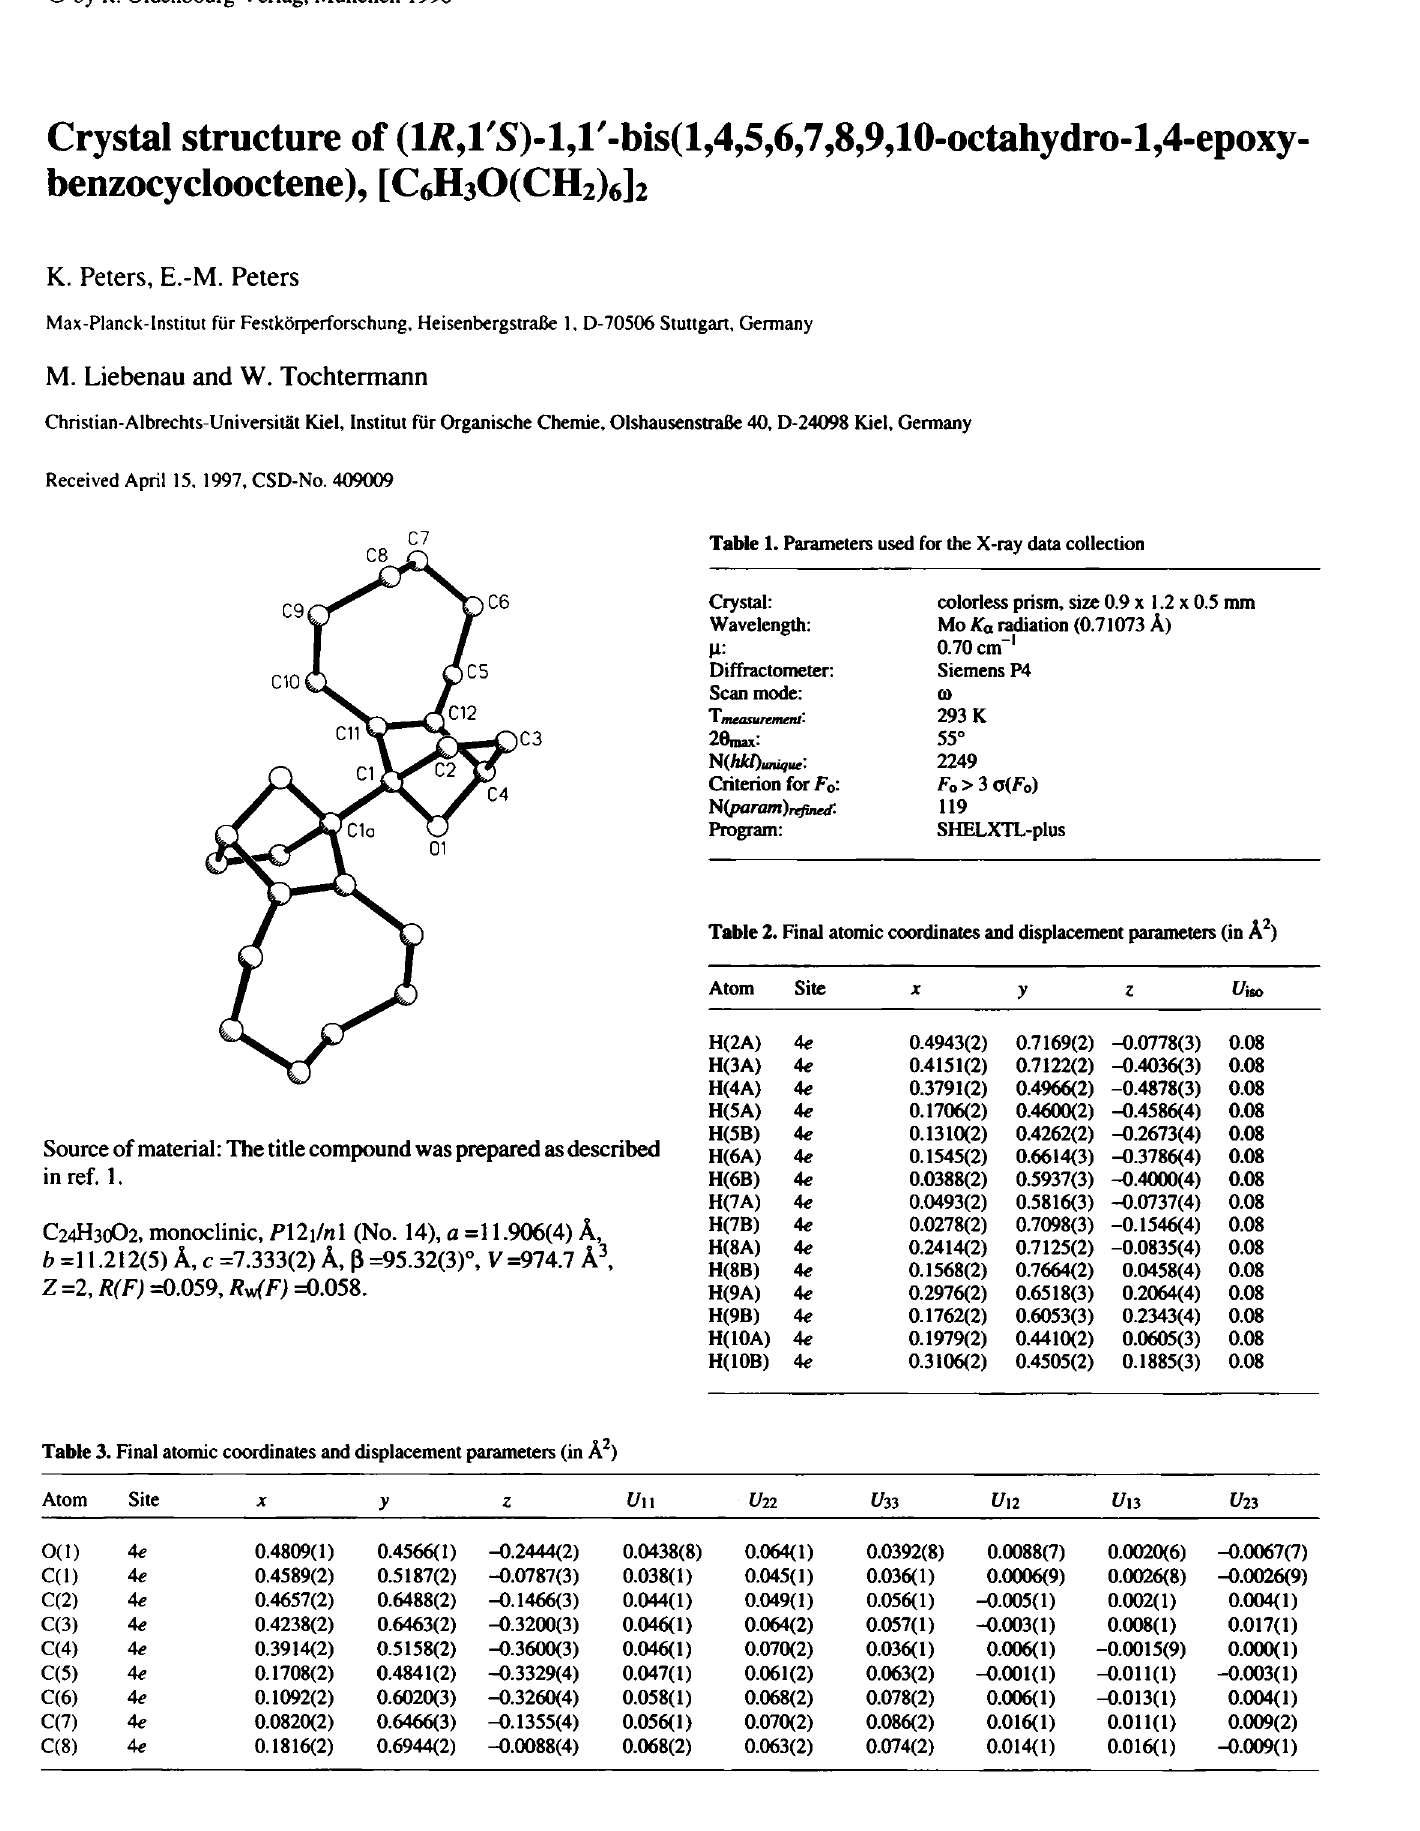
Table 1. Parameters used for the X-ray data collection Crystal: